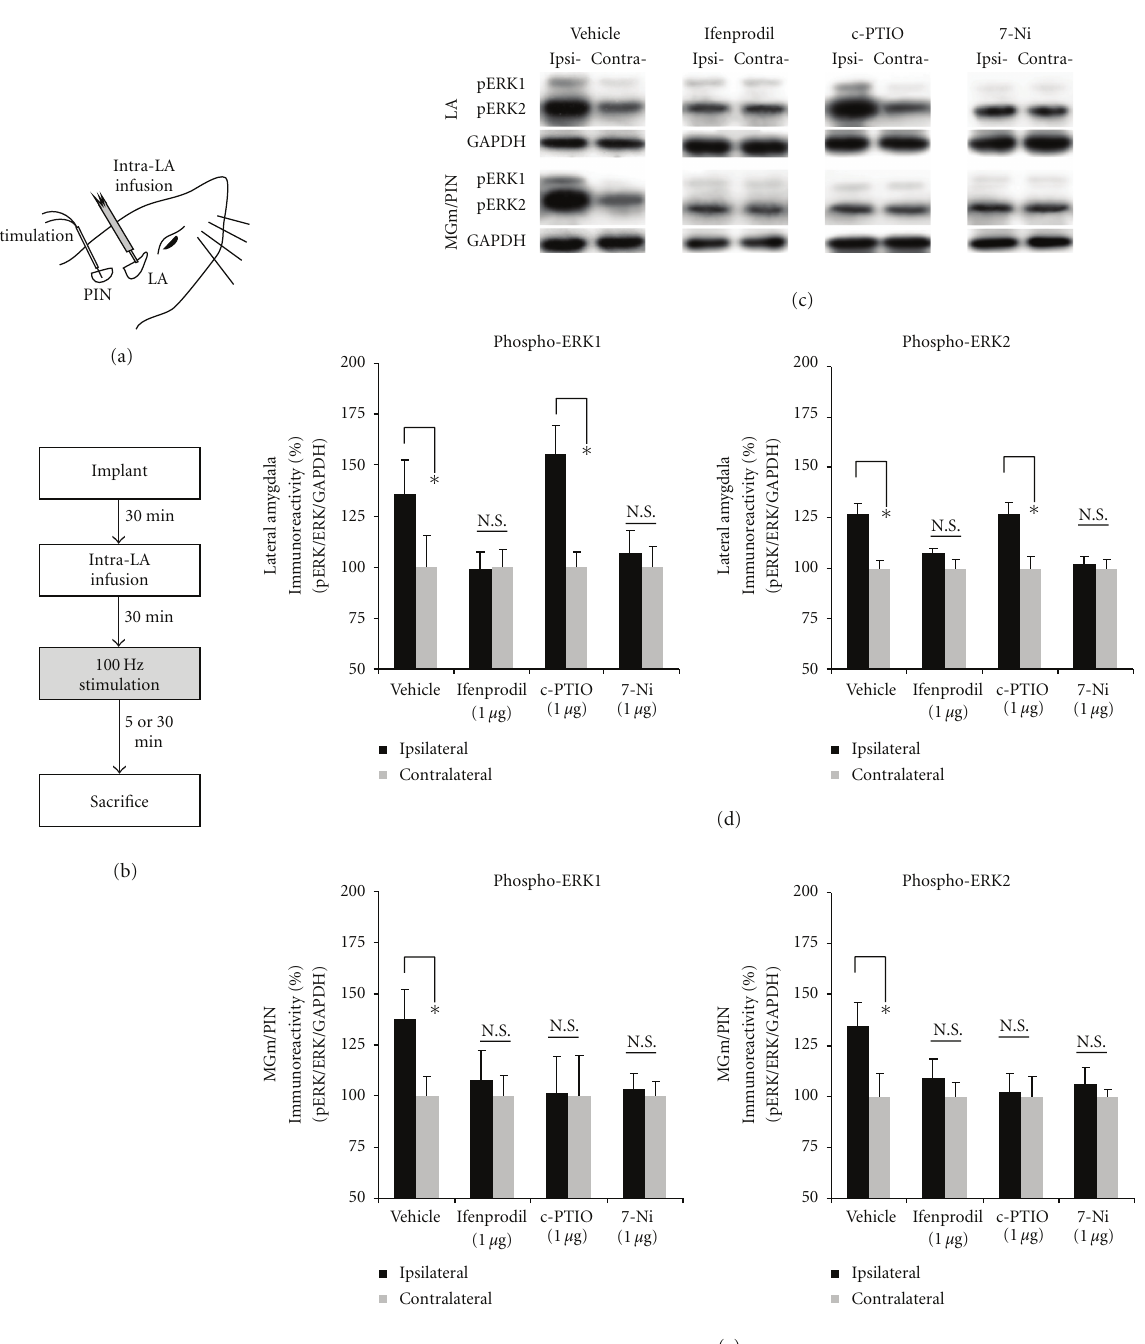
Figure 5: Pharmacological blockade of NMDAR-driven synaptic plasticity or NOS activation in the LA impairs ERK activation in both the LA and MGm/PIN following HFS, while blockade of extracellular NO impairs ERK activation in the MGm/PIN but not LA. (a) Placement of stimulation electrode and infusion cannula. (b) Schematic representation of the experimental protocol. Rats were given intra-LA infusion of the vehicle or drug (1 μ g/side) followed 30min later by HFS of the MGm/PIN. Rats were sacrificed at 5min (for the LA group) or 30 min (for the MGm/PIN group) following stimulation. (c) Images of Western blots for phospho-ERK1/2 and associated GAPDH controls from LA (top) and MGm/PIN (bottom) samples. (d) Mean ( ± SEM) percent phospho-ERK1/2 immunoreactivity from LA punches taken from rats given intra-LA infusions of 50% DMSO (vehicle; n = 5), 1 μ g/side ifenprodil ( n = 5), 7-Ni ( n = 6) or c-PTIO ( n = 5). (e) Mean ( ± SEM) percent phospho-ERK1/2 immunoreactivity from MGm/PIN punches taken from rats given intra-LA infusions of 50% DMSO (vehicle; n = 5), 1 μ g/side ifenprodil ( n = 6), 7-Ni ( n = 6) or c-PTIO ( n = 5). For each figure, phospho-ERK1/2 levels have been normalized to total-ERK1/2 levels for each sample and counts on the ipsilateral side have been expressed as a percentage of those on the contralateral side. ∗ P < . 05 relative to the ipsilateral side N.S. = not